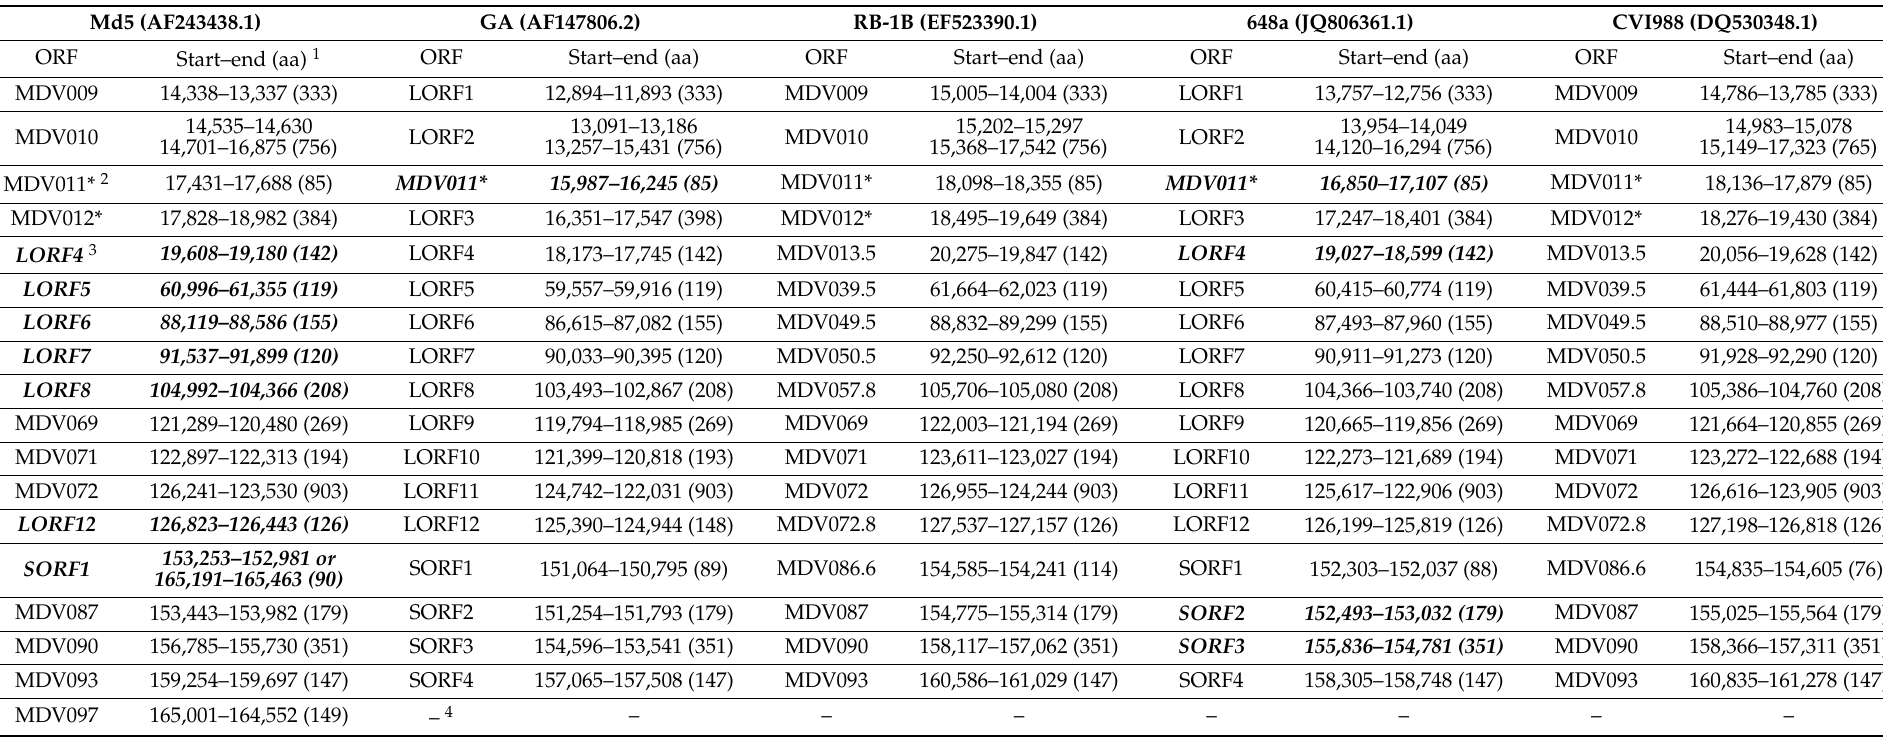
Table 1. Unique open reading frames (ORFs) encoded by unique long (UL) and short (US) regions of different MDV